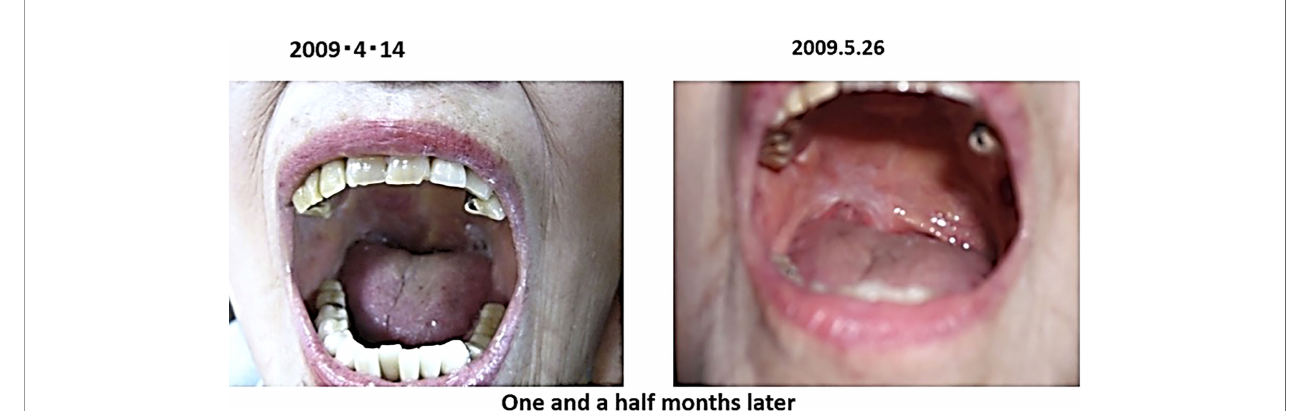
FIGURE 5 | Her photographs of right tonsil are shown.